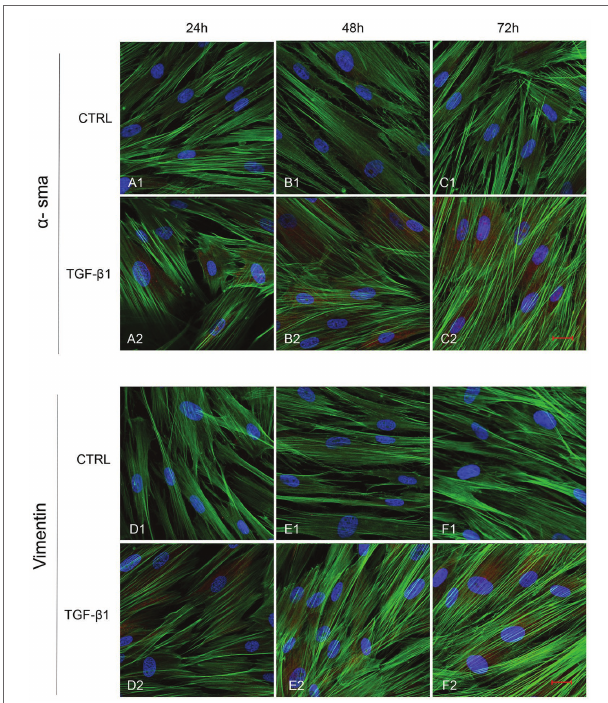
FIGURE 4 | Human GFs uninduced and induced with TGF- β 1 (10 ng/ml) were observed after 24, 48, and 72 h incubation. α -SMA specific marker evaluation in untreated (A1-C1) and TGF- β 1 treated cells (A2-C2) . Vimentin specific marker evaluation in untreated (D1-F1) and TGF- β 1 treated cells (D2-F2) . Red fluorescence: specific marker; green fluorescence: cytoskeleton actin; blue fluorescence: nuclei. Scale bar: 20 μ m; magnification 40x.